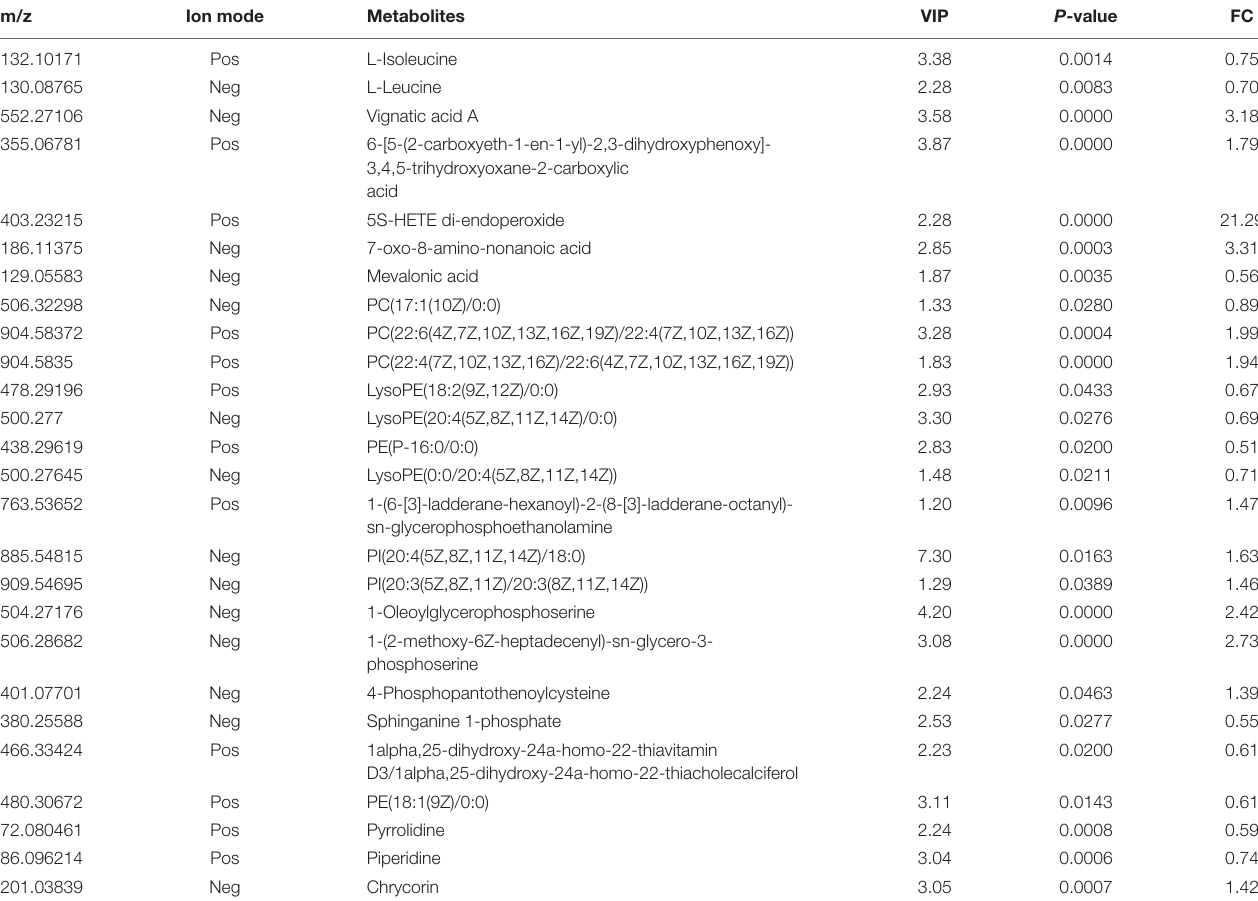
TABLE 3 | Summary of the differentially expressed metabolites between PHx and PHx + AR113 groups. m/z Ion